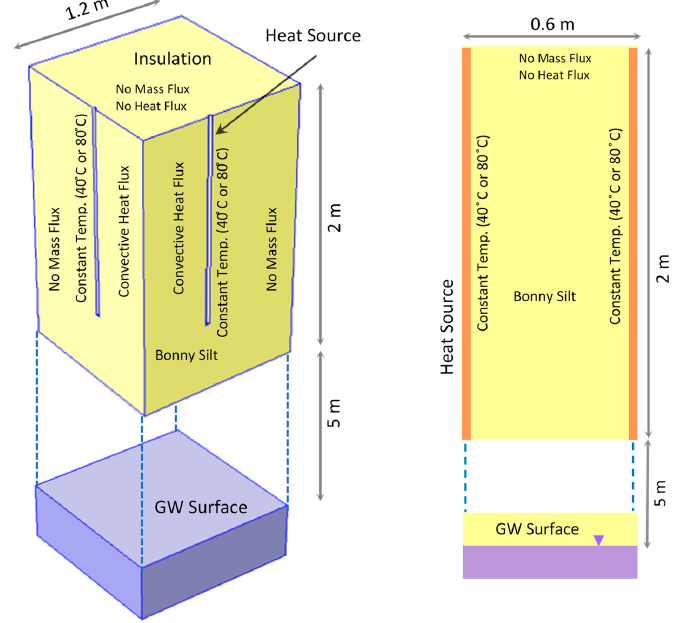
Figure 3. Three- and two-dimensional schematics of the simulated domain as well as boundary conditions used in the simulation. Due to symmetry, only a quarter of the domain is modeled. The line heat sources have a constant temperature (40 °C or 80 °C). The side boundaries are modeled as convective heat transfer boundaries. It is assumed that the surface of the domain is insulated (GW: Ground Water).